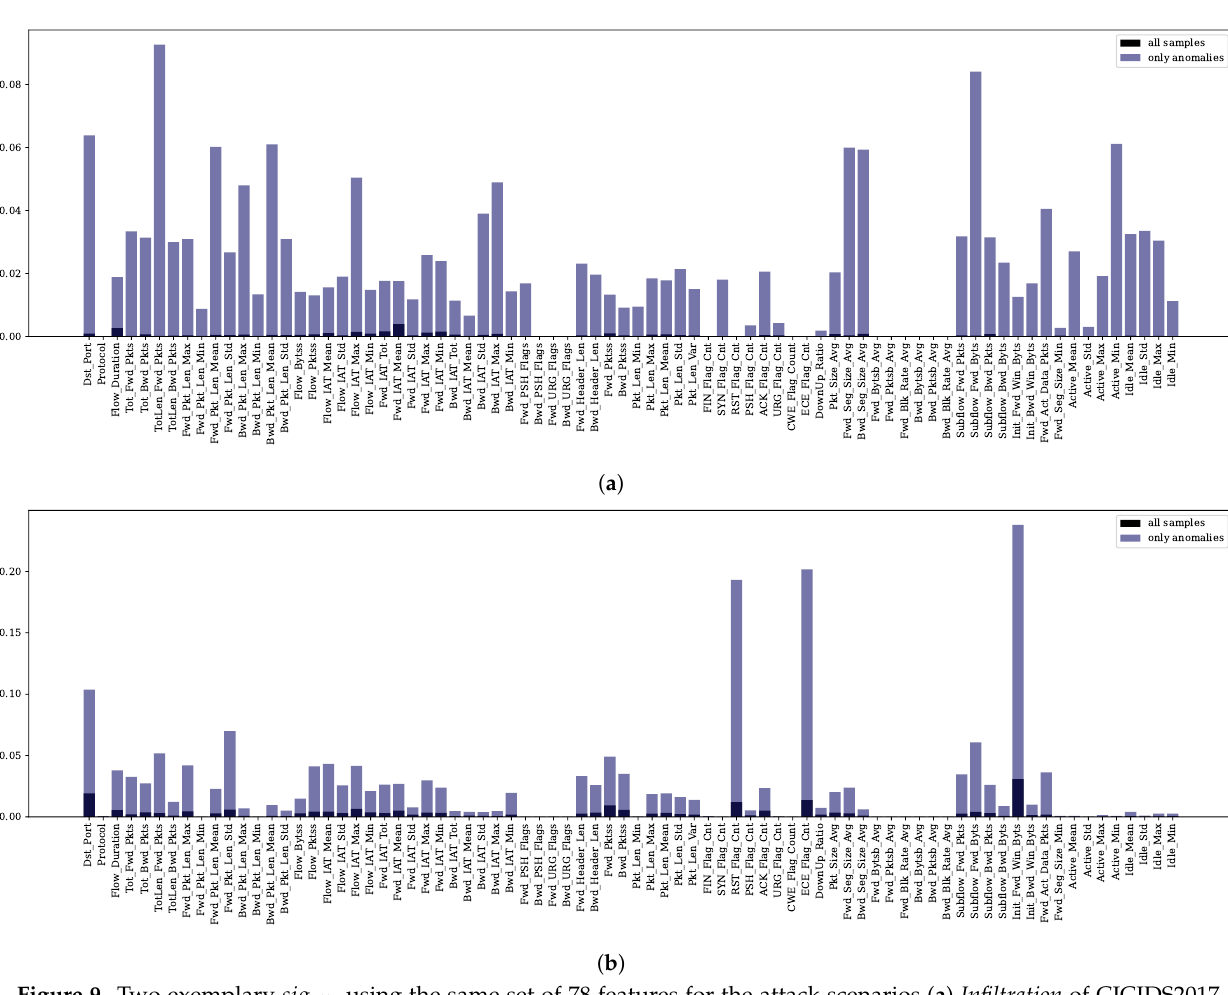
Figure 9. Two exemplary sig attr using the same set of 78 features for the attack scenarios ( a ) Infiltration of CICIDS2017 and ( b ) Brute-Force-Web-0 in CSE-CIC-IDS2018 (two colors for feature importance on all samples and only on anomalous samples— sig attr